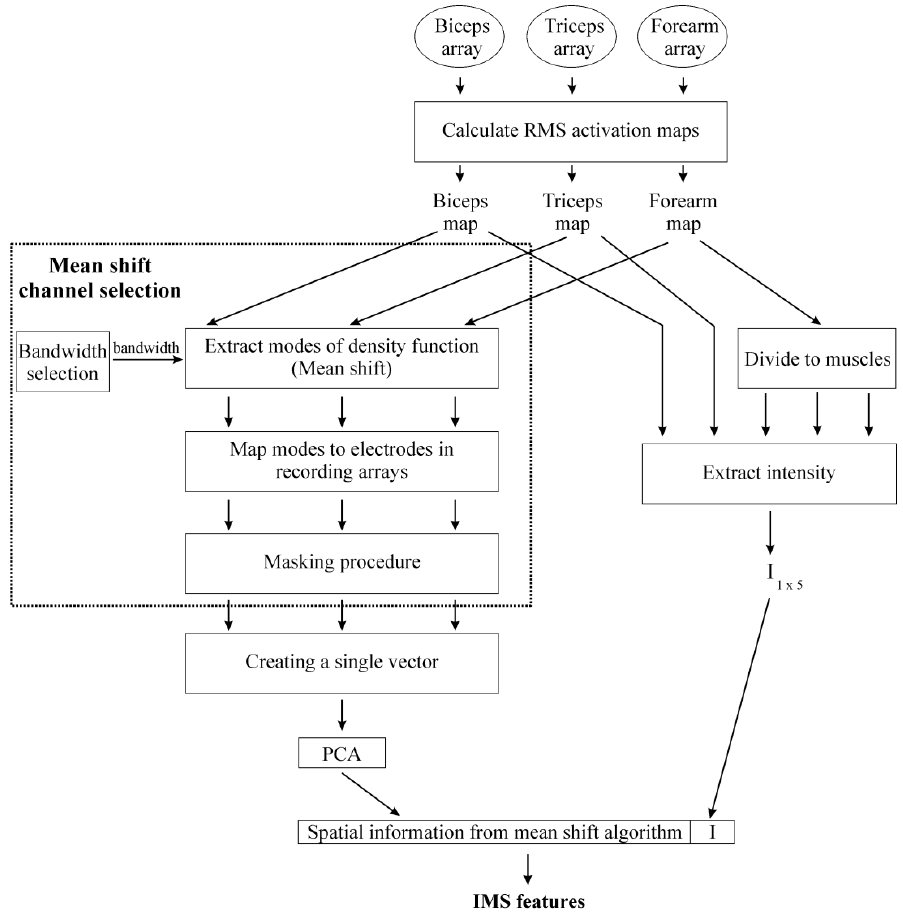
Figure 2. Feature extraction flowchart.